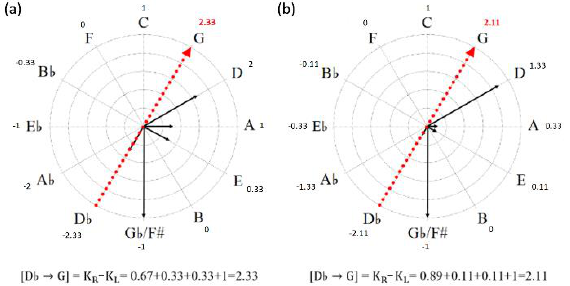
Figure 3. The directed axes of the signatures of fifths corresponding to the fragment of the piece of music presented in Figure 1: ( a ) obtained for the multiplicities of occurrences of individual pitch-classes; ( b ) obtained for the aggregate durations of individual pitch-classes.